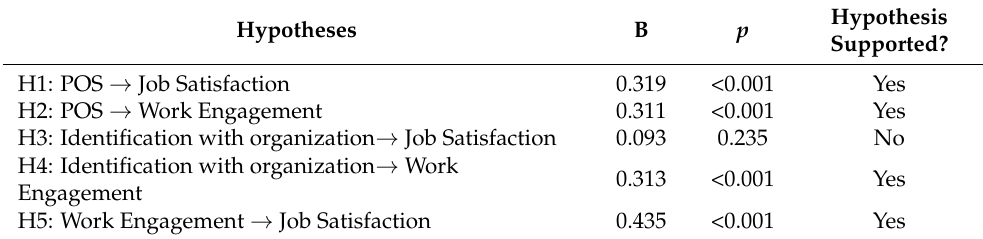
Table 5. Results of proposed hypotheses.